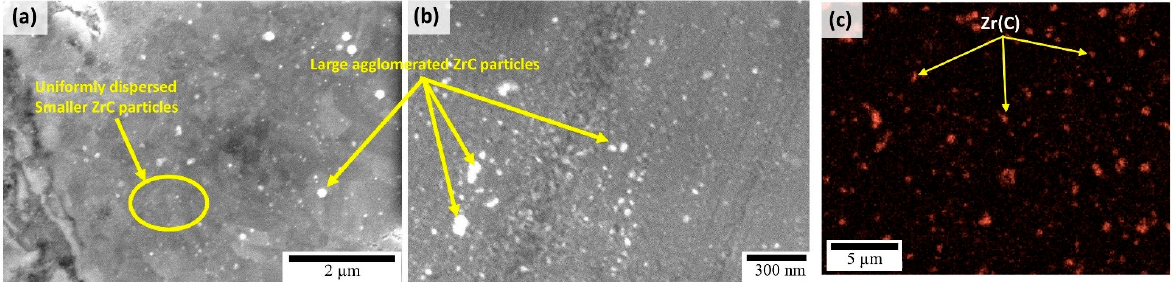
Figure 7. Fe-5 vol.% ZrC milled in Retsch mill for 6 h ( a ) SEM secondary electron image revealing the overall dispersion of the ZrC NPs (bright feature) ( b ) High magnification SEM secondary electron image, ( c ) EDS spectral map revealing Zr signals from the NPs.